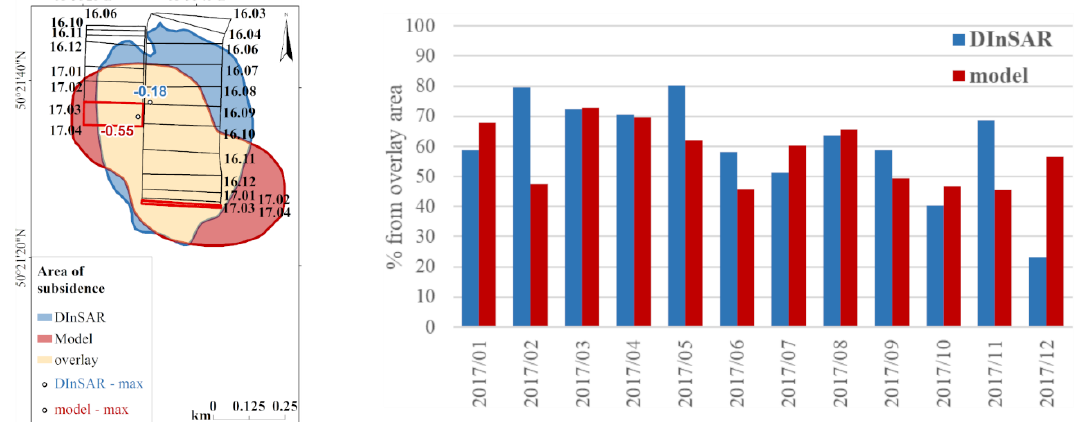
Figure 11. Areal resemblance between Differential satellite radar interferometric (DInSAR) measured and expected range of surface deformation; Left : Example for March; Right : Percentage in the overlay area.